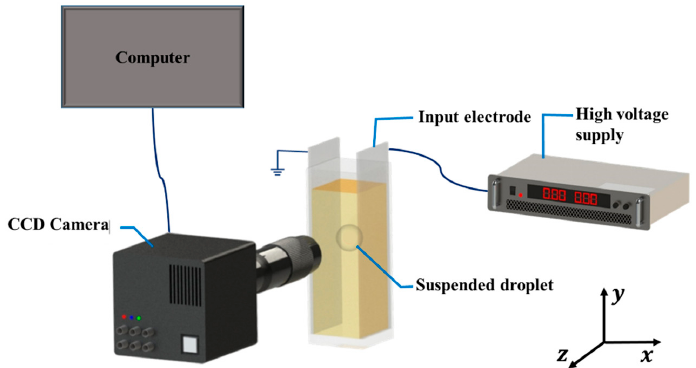
Table 2 . Liquid systems used in the study .